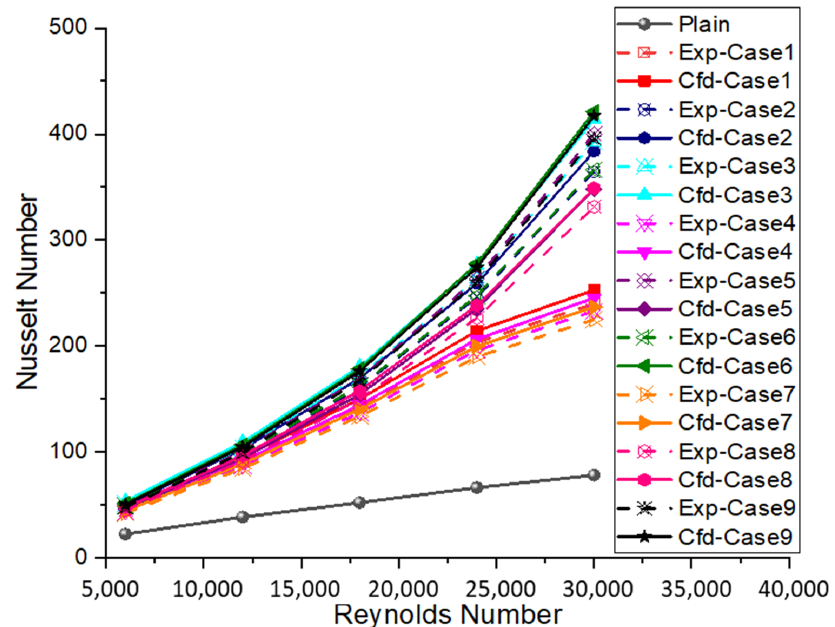
Figure 9. Augmented values of Nusselt Number over Reynolds Number.